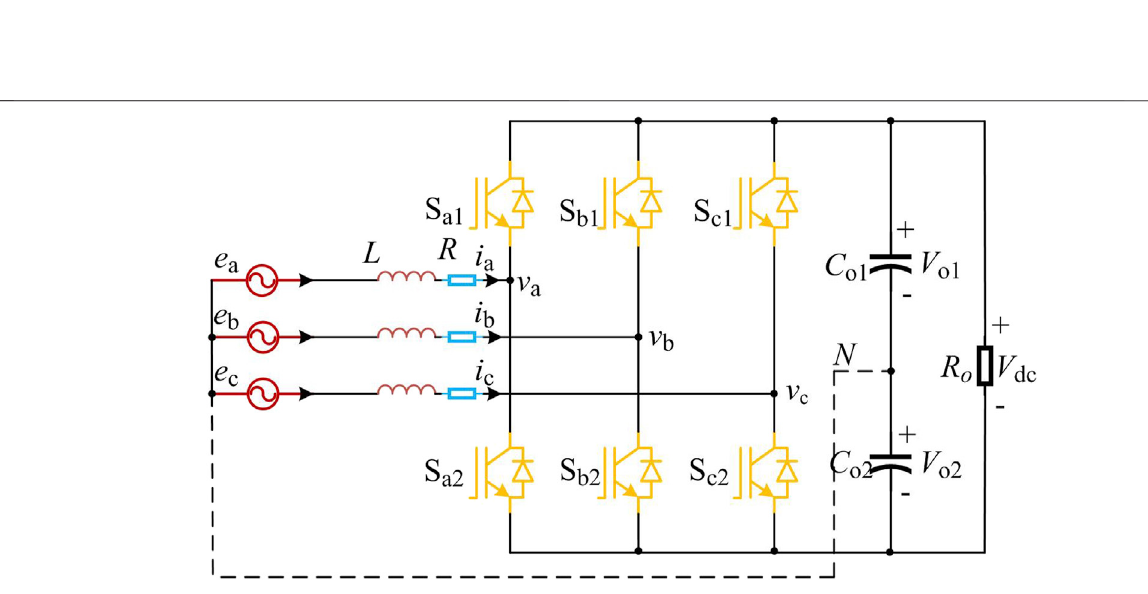
Frontiers in Energy Research |